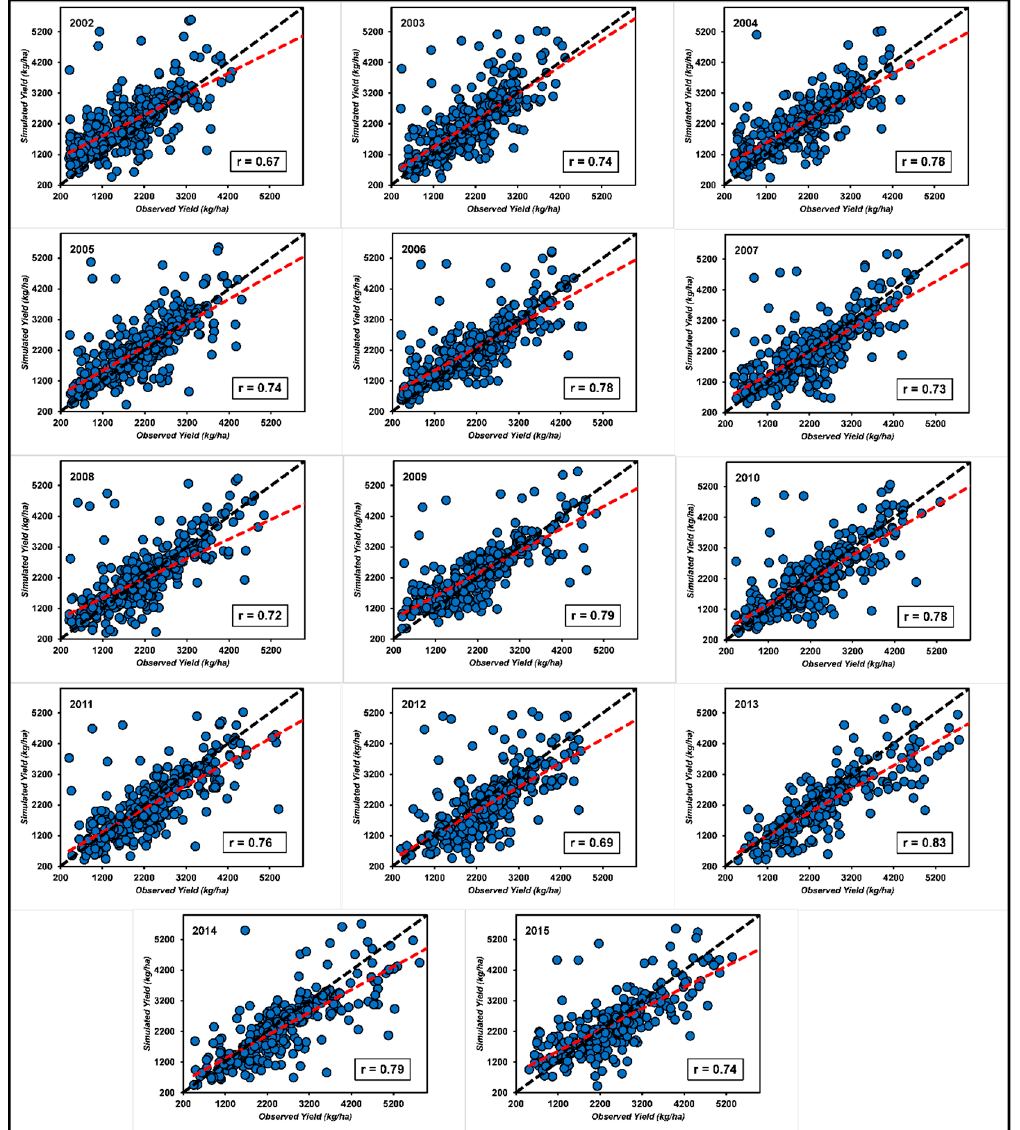
Figure 4. Comparison between district-level observed and simulated yield for the model calibration years (2001 to 2015). The black line describes a 1:1 ratio, and the red line explains the regression fit between observed and simulated yields.